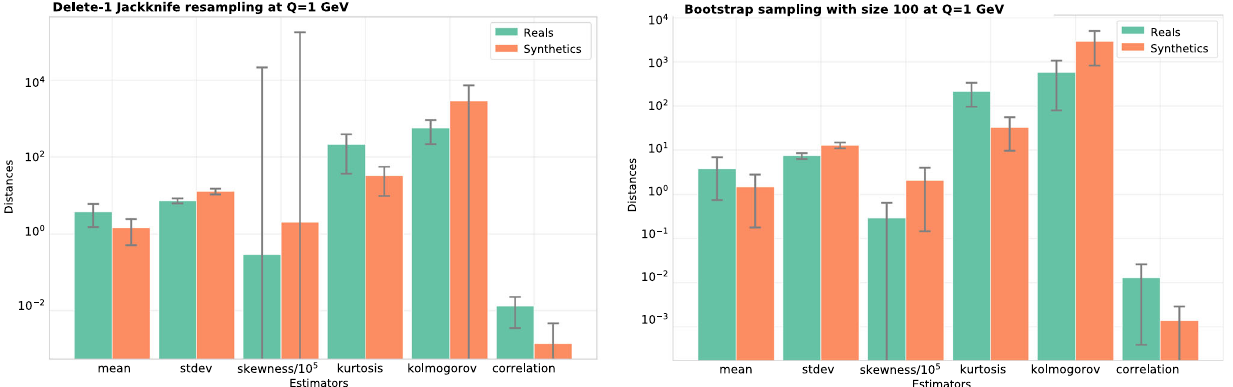
Fig. 15 Comparison of the real and synthetic fits for various statisti- cal estimators. The histograms are constructed by measuring the dis- tance between S 1 -S 2 (Reals) and S 1 -S 3 (Synthetics). The error bars are